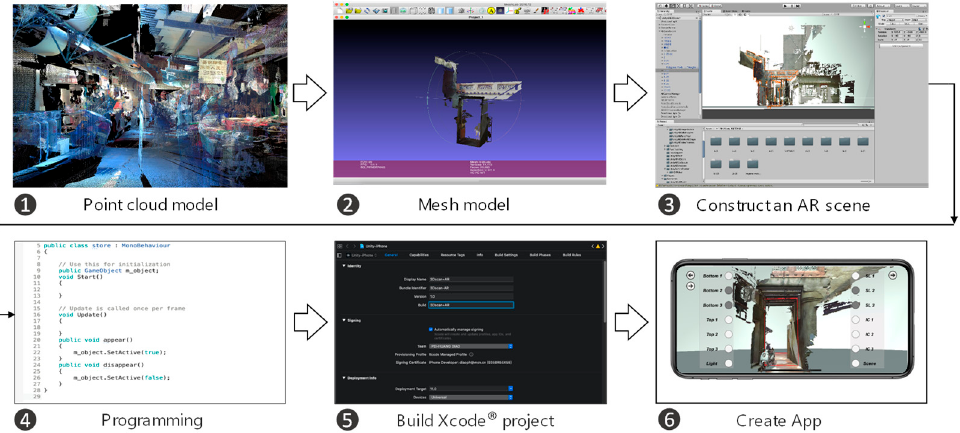
Figure 8. System structure.